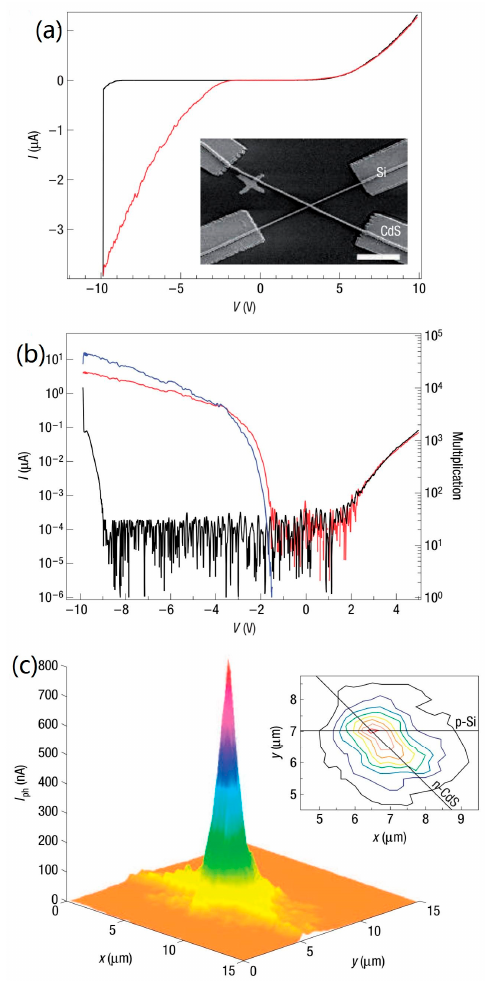
Figure 16. Characterization of nanowire avalanche photodiodes. ( a ) I-V characteristic of the avalanche photodiodes in dark (black line) and illuminated (red line) conditions; the device was illuminated with 500 nW of 488-nm light (red line). The inset shows a scanning electron micrograph of the n-CdS/p-Si device; the scale bar is 4 µ m. ( b ) Logarithmic scale of avalanche photodiodes I-V characteristics (black line: dark; red line: illuminated) and the corresponding multiplication factor (blue line). ( c ) Plot of the spatially-resolved photocurrent from the nano-avalanche photodiodes measured in the proportional mode using a diffraction-limited laser; the bias voltage, laser power and scanning step size were − 7 V, 200 nW, and 250 nm (in x and y ), respectively. The inset shows a contour plot with slices taken every 100 nA. The nanowire positions are indicated on the plot by solid lines. Reproduced with permission from [44], Copyright 2006, Nature Publishing Group.